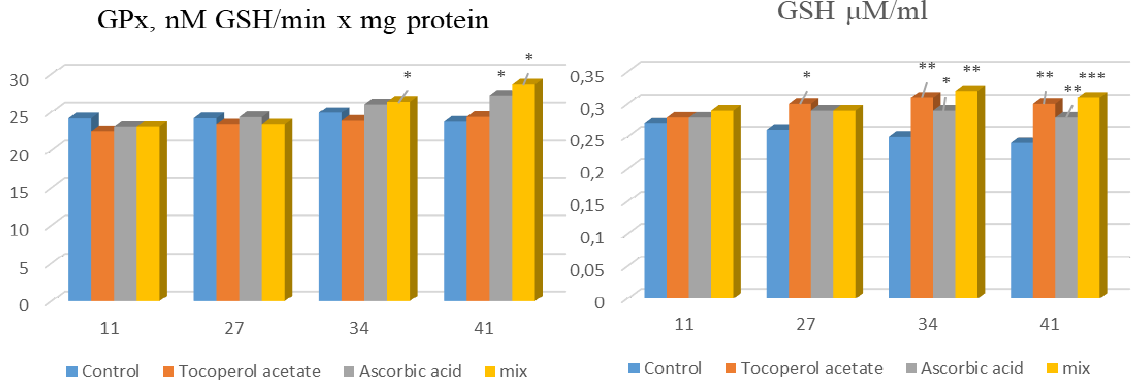
Fig. 1. Glutathione peroxidase activity and content of reduced glutathione in broiler chickens blood ( М ± m; n = 5)